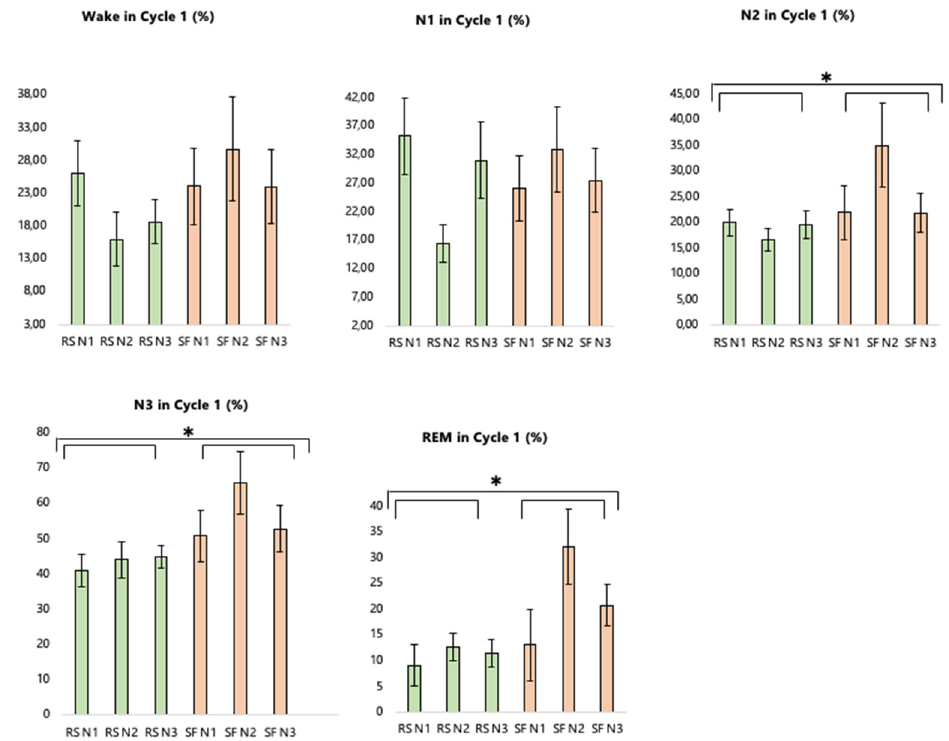
Figure 6. Polysomnographic parameters in control (RS) and fragmented (SF) sleep during the first sleep cycle. Wake in Cycle 1 (%) = percentage of Wake; N1 in Cycle 1 (%) = percentage of N1; N2 in Cycle 1 (%) = percentage of N2; N3 in Cycle 1 (%) = percentage of N3; REM in Cycle 1 (%) = percentage of REM. Error bars represent standard errors. * p < 0.05